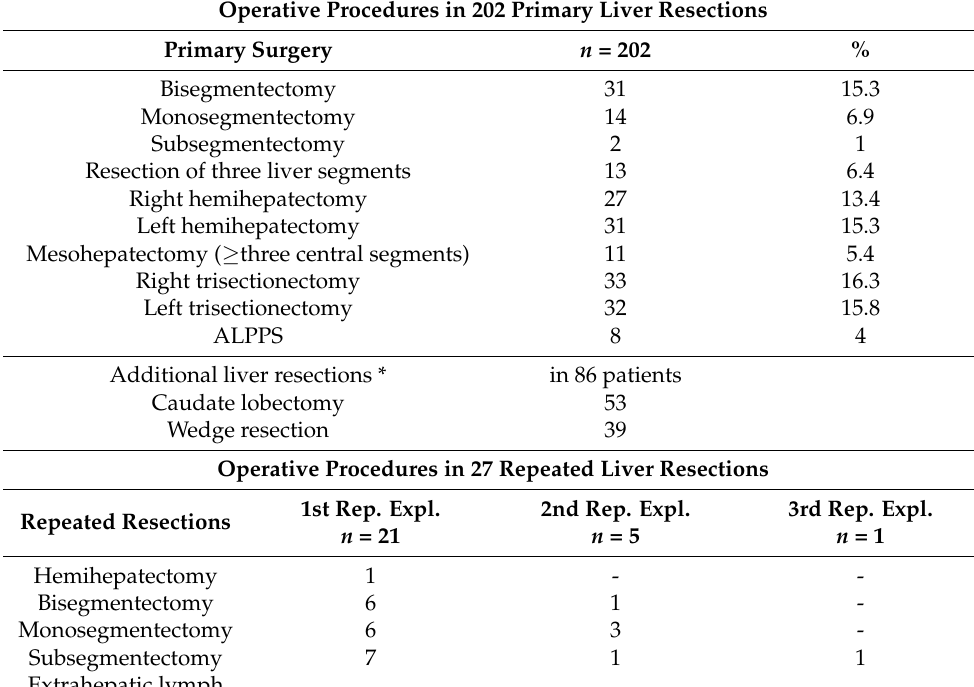
Table 2. Operative Procedures in liver resections.